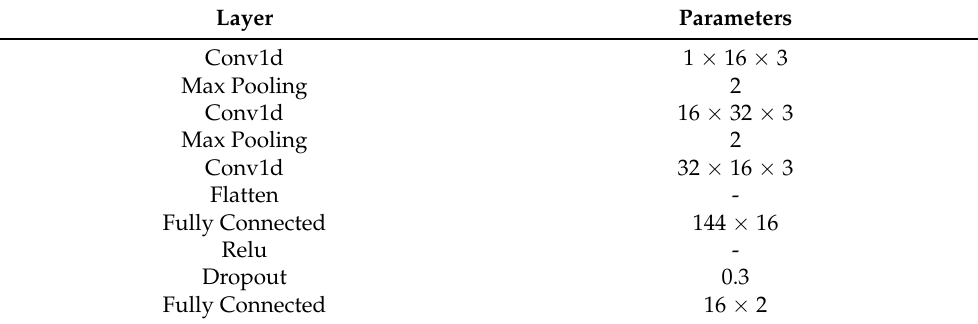
Table 3. The CNN